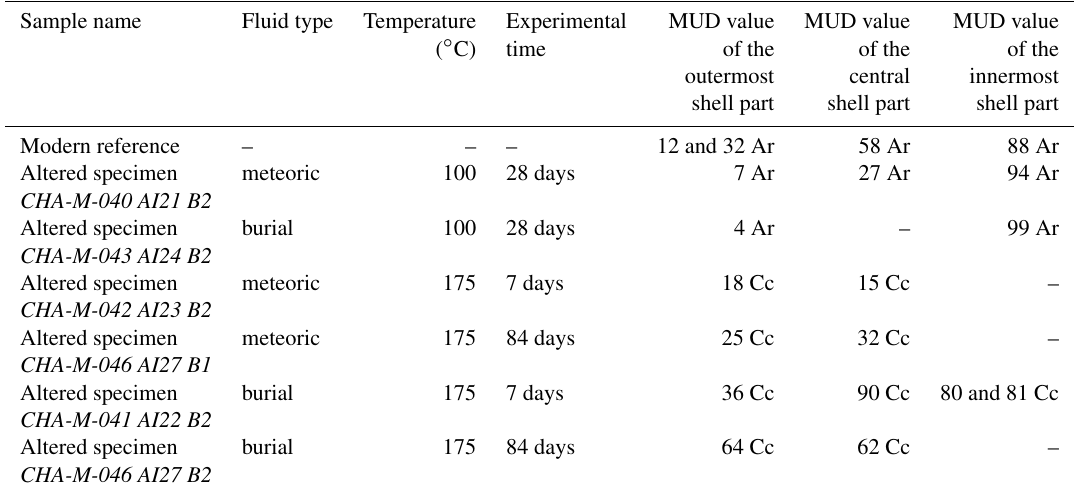
Table 2. Crystal co-orientation (texture) strength expressed as multiple of uniform (random) distribution (MUD) of modern and experimen- tally altered Arctica islandica shells. Ar: aragonite; Cc: